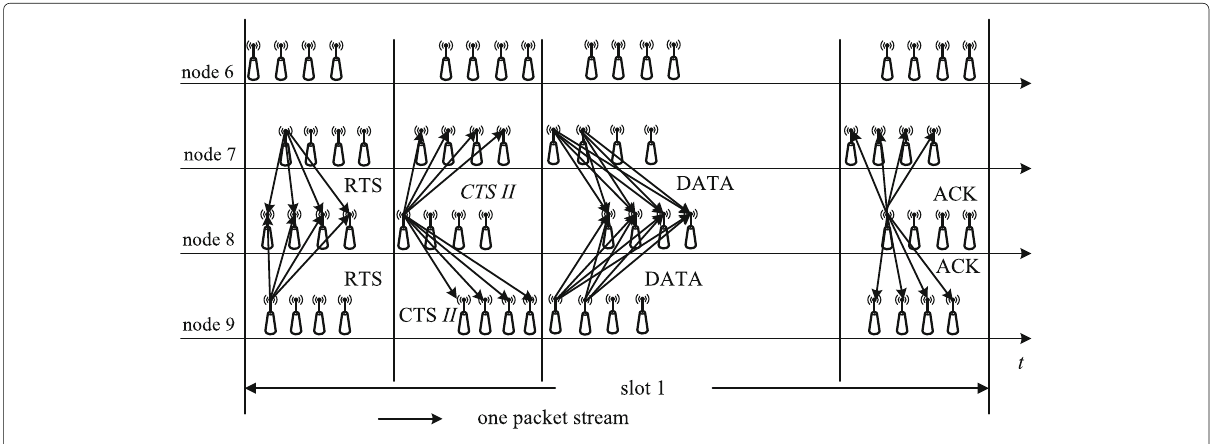
Fig. 3 Node receives 2 RTS